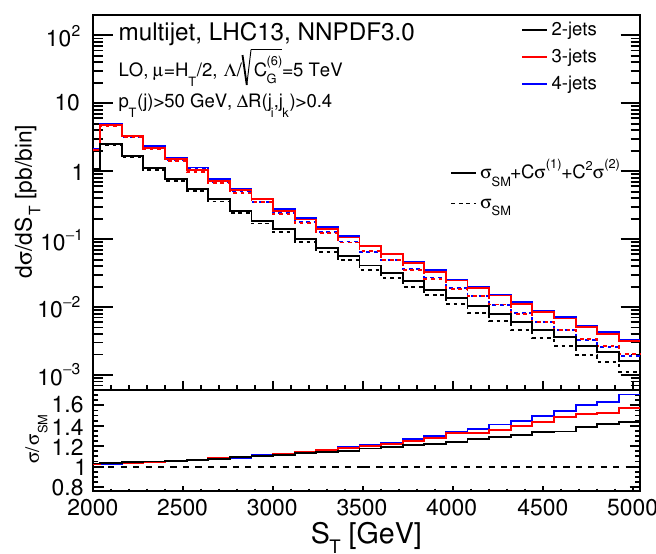
Figure 1 . Impact of jet multiplicity on the sensitivity to O G for multi-jet production at LHC13. A maximum of one insertion of the O G operator is allowed in all of the amplitudes considered and the O (1 = (cid:3) 4 ) contributions are